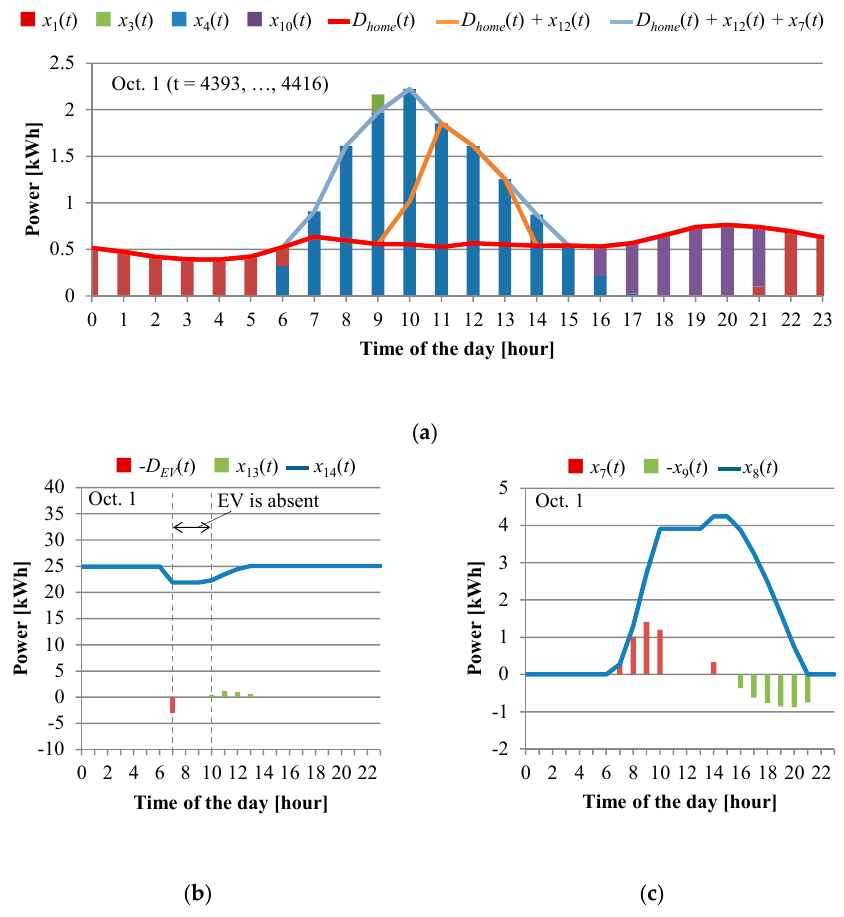
Figure 9. Optimized energy flow in case 3 on the day with large amount of PV power generation ( a ) residential supply-demand balance, ( b ) operation schedule of EV battery, and ( c ) operation schedule of SB.